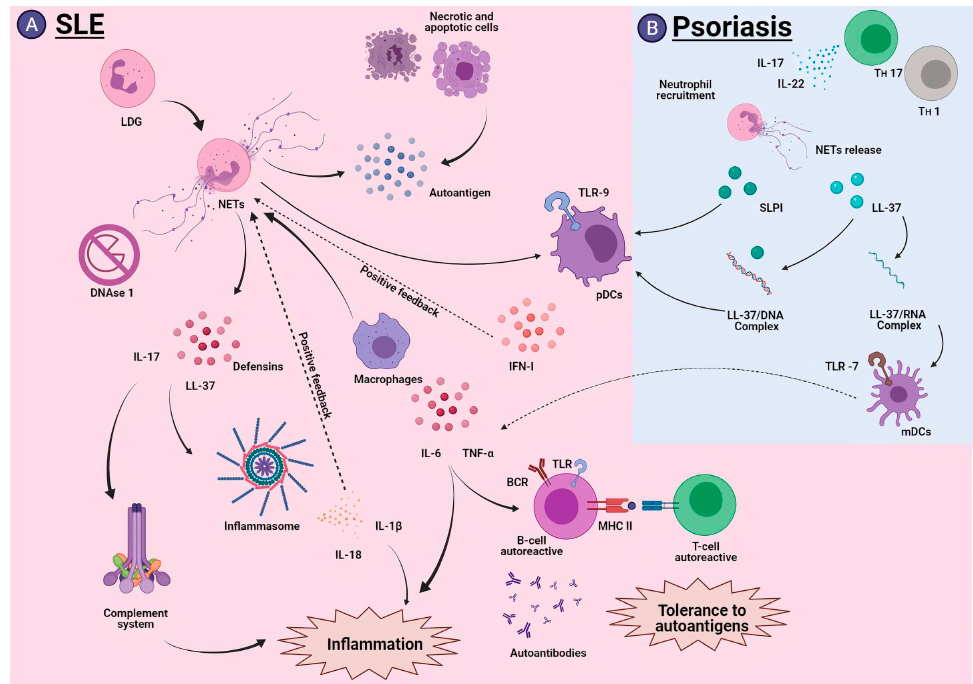
Figure 5. NETs in SLE and psoriasis. ( A ) During the development of SLE, LDGs are the main producers of NETs, which accumulate due to the DNAse 1 inhibition preventing their degradation. NETs have detrimental effects in SLE, since they release components such as LL-37 and IL-17 that activate the inflammasome and the complement system. NETs are internalized by macrophages, which release proinflammatory cytokines that lead to activation of autoreactive B cells and subsequent presentation to T cells and tolerance to autoantigens. Finally, NETs activate pDCs efficiently and stimulate IFN-I production, generating positive feedback to release more NETs. ( B ) Th17 cells are the main mediators of psoriasis by secreting IL-17; they promote neutrophil recruitment, and subsequently NET release. Their components stimulate the activation of pDCs directly (SLPI) or by DNA complexes (LL-37), to produce more IFN-I. In addition, LL-37 can form RNA complexes that promote the activation of mDCs and exacerbate the inflammatory process. SLE, systemic lupus erythematosus; LDG, low-density granulocytes; NET, neutrophil extracellular trap; LL-37, cathelicidin; IL-17, interleukin-17; pDC, plasmacytoid dendritic cells; IFN-I, type I interferon; SLPI, secretory leukocyte protease inhibitor; mDC, myeloid dendritic cells; mDC, myeloid dendritic cells. Created with BioRender.com